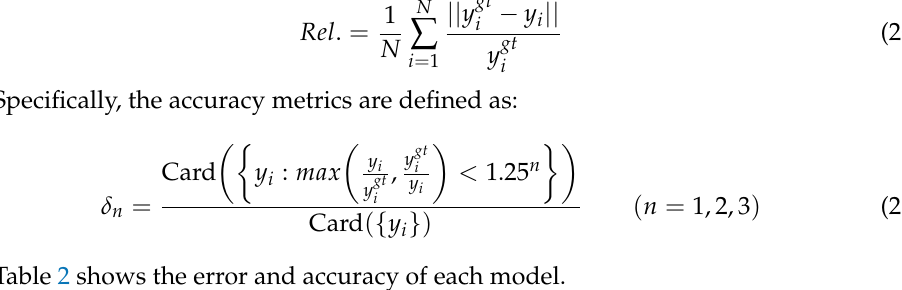
Table 2. Preliminary evaluation of our proposed method regarding the error and accuracy. Error (Lower Is Better) Accuracy (Higher Is Pixel Interval